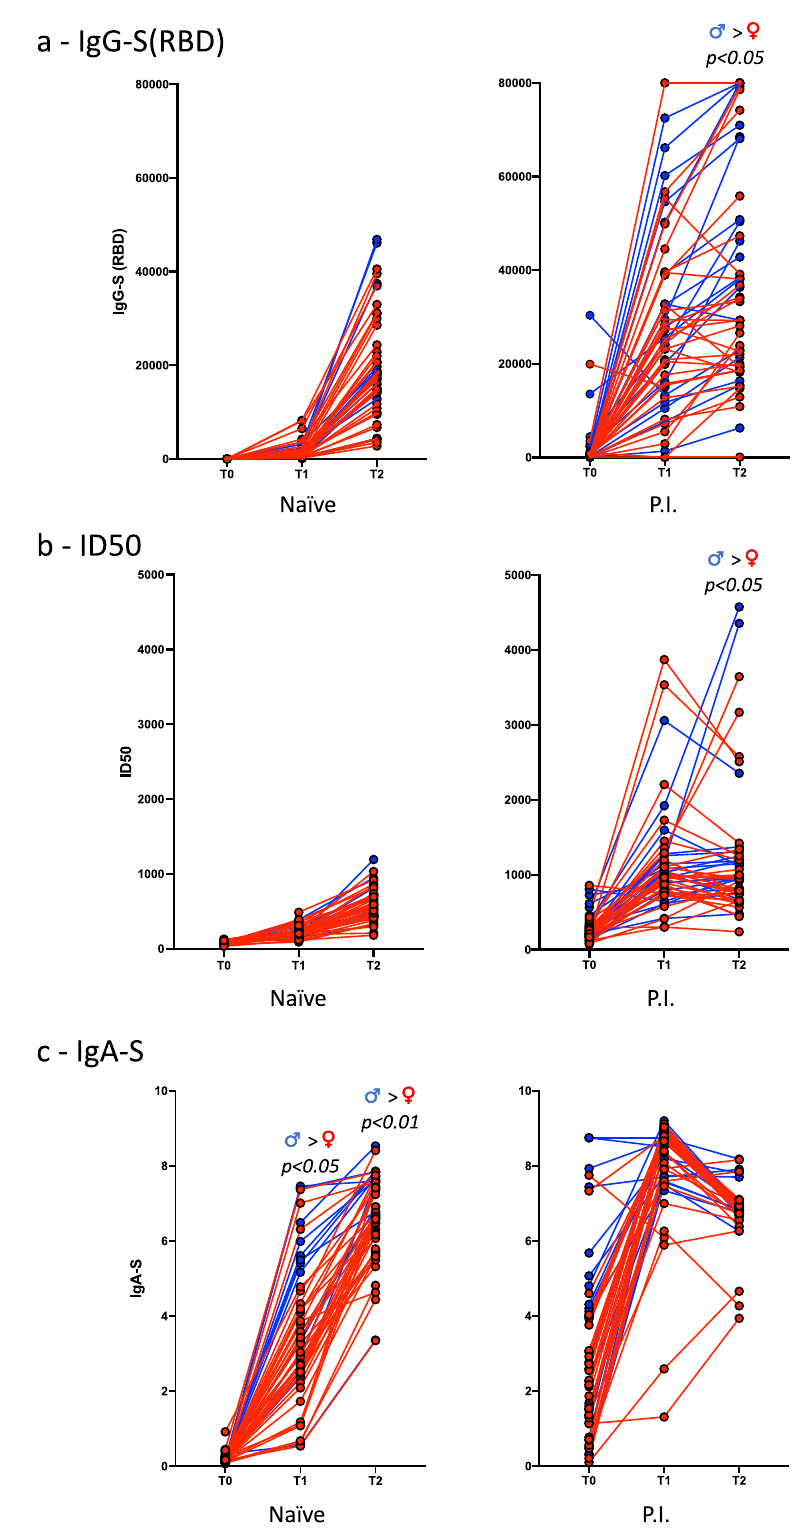
Fig. 4 Antibody response in naïve and previously infected (P.I.) male (blue dots) and female (red dots) subjects following vaccination. a IgG-S(RBD) titers at the time of fi rst vaccination (T0, n . males/females 12/36 for naïve, 19/32 for P.I.), second vaccination (T1, n . males/females 13/37 for naïve, 19/32 for P.I.), and 3 weeks after the boost (T2, n . males/females 13/36 for naïve, 19/30 for P.I.); b neutralization activity expressed as ID50 ( n . males/females: T0 12/36, T1 13/37, T2 13/36 for naïve, T0 19/32, T1 19/32, T2 19/31 for P.I.); c IgA-S antibody titers ( n . males/females: T0 12/37, T1 13/37, T2 13/36 for naïve, T0 19/32, T1 19/32, T2 18/31 for P.I.). P values were calculated using the Wilcoxon matched-pairs signed ranked test and considered signi fi cant if p <